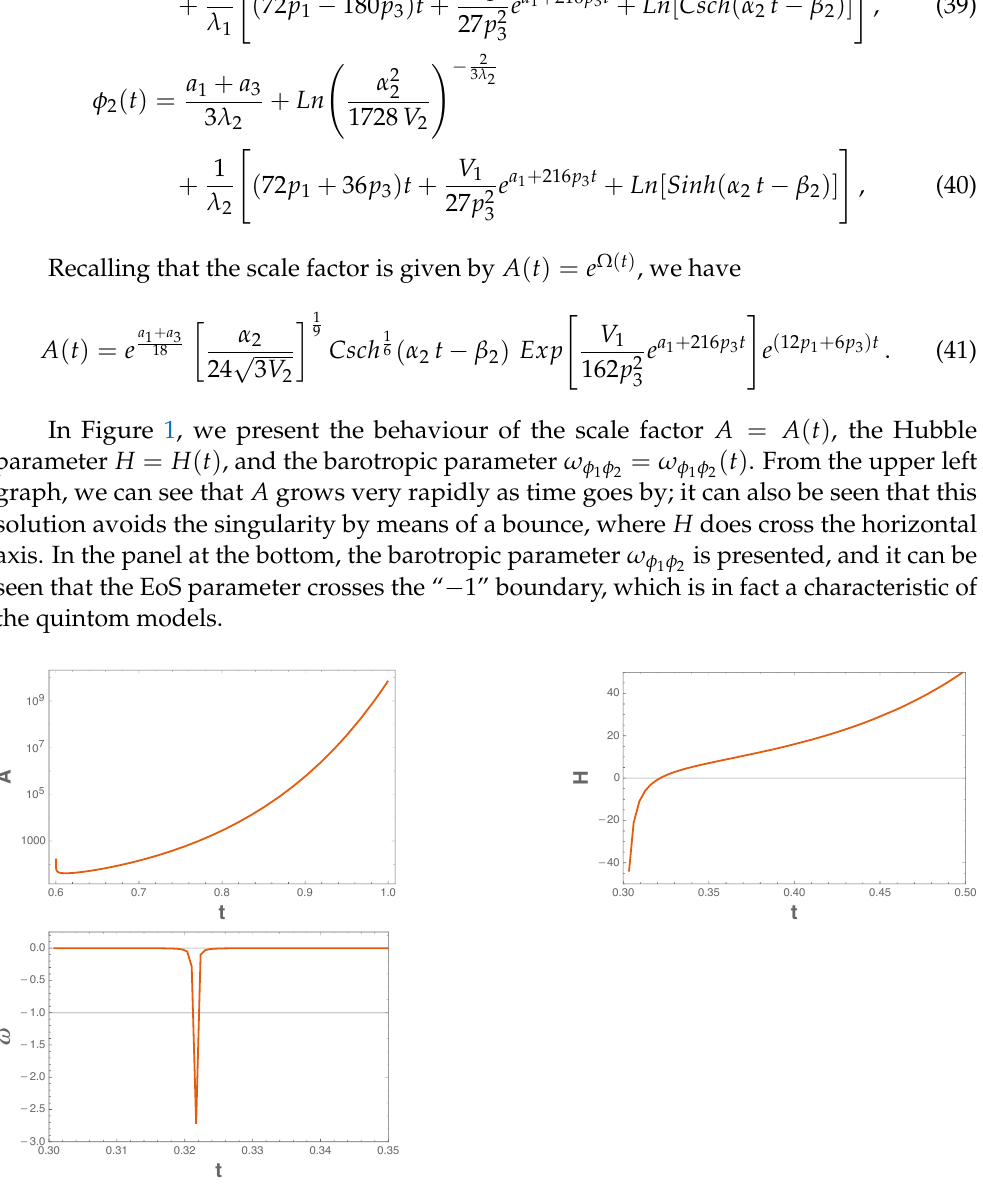
Figure 1. This figure shows the time (0.3 ≤ t ≤ 1.0) evolution of the scale factor A ( t ) , the Hub- ble parameter H ( t ) , and the barotropic parameter ω φ V 1 = 6.0, V 2 = 0.1, α 2 = 3.0, a 1 = − 6.548, a 3 = − 2.0, and p 1 = 0.001. Recall that λ 1 = λ 2 =